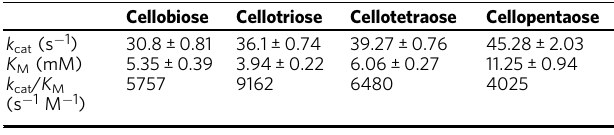
a Apparent kinetic parameters using the dehydrogenase assay. The kinetic parameters are determined from a global fi t of the Michaelis-Menten expression to triplicate ( n = 3 independent experiments), except for cellopentaose ( n = 1 experiment). The data are shown as means± standard deviations. For cellopentaose the error estimates of the fi t to the single data set are